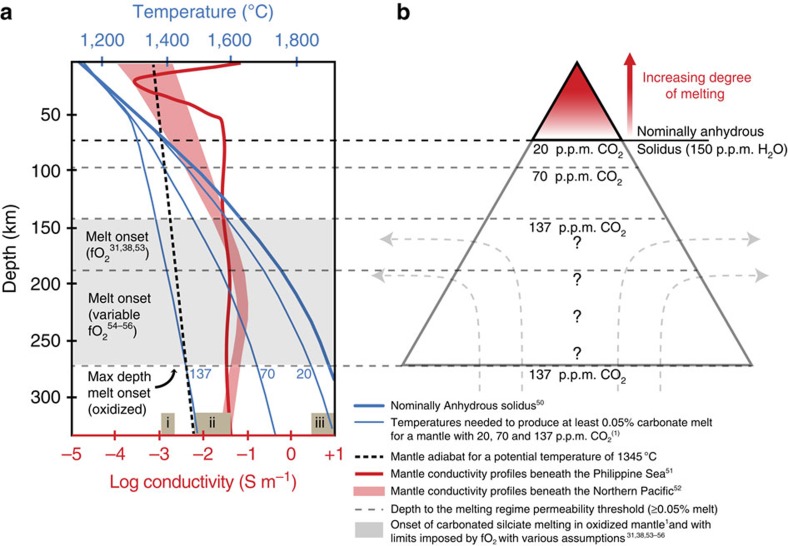
Simplified model of mantle melting.(a) Variation of melting temperatures with depth as a function of mantle CO2 content (blue curves)250, and electrical conductivity versus depth (red curves) for the upper mantle beneath the Philippine Sea51 (thin red curve) and north Pacific52 (broad red curve). Shaded boxes at the base of the plot represent the range of laboratory electrical conductivity measurements for dry olivine (i), olivine containing 150 p.p.m. H2O (ii) and melt (iii) (refs 30, 50). (b) Schematic cross-section of the permeable melting regime beneath a mid-ocean ridge based on a, using the same vertical scale, a mantle potential temperature of 1,345 °C and a permeability threshold of 0.05%. At depths below the nominally anhydrous solidus, melting is dominated by small fractions of carbonate and carbonated silicate melt. Shaded grey zones indicate possible, depths for carbonated silicate melt initiation depending on the oxygen fugacity (fO2) of the mantle53545556. Onset at the carbonated silicate solidus1 assumes that mantle fO2 is high enough to stabilize carbonate over diamond at 275 km. If the mantle is more reducing, melting will instead initiate at the fO2-dependent diamond to carbonate transition. Melt initiation between 140 and 180 km encompasses whole rock Fe3+/ΣFe ratios from 0.035 to 0.05 based on the continental xenolith record38—depths that are also consistent with a range of MORB Fe3+/ΣFe ratio, Fe3+ bulk partition coefficients, and primitive mantle Fe2O3 contents19 and the assumption that 37p.p.m. C has the power to reduce Fe3+/ΣFe by >1% as it oxidizes to carbonate. Because the subsolidus Fe3+/ΣFe ratio of the mantle and the depth of metal saturation are uncertain, the depth of melt initiation is also uncertain.